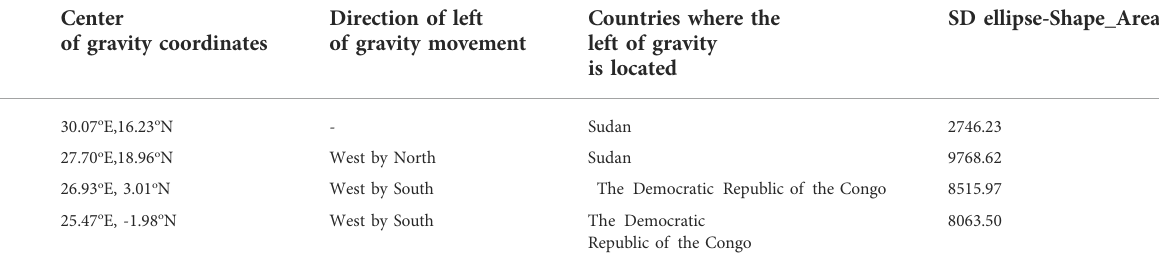
TABLE 1 Spatial attributes of biodiversity